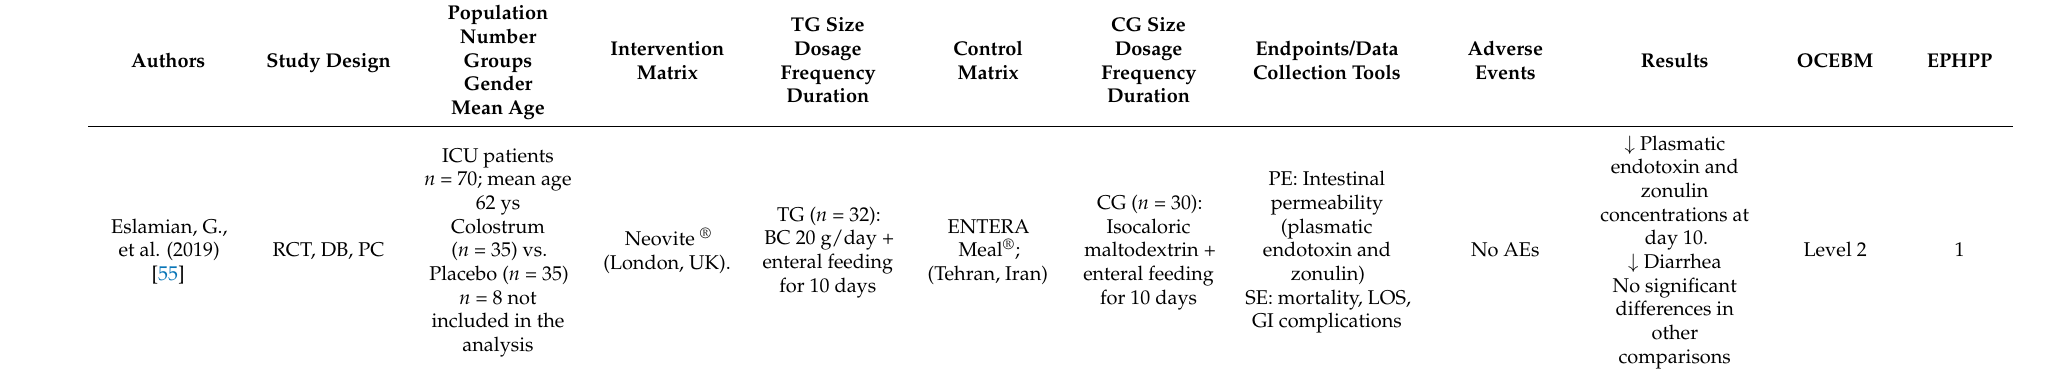
Table 6. BC administration in critically ill